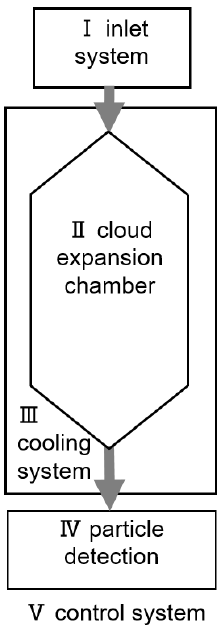
Figure 1. Scheme of a PINE instrument with its five basic compo-